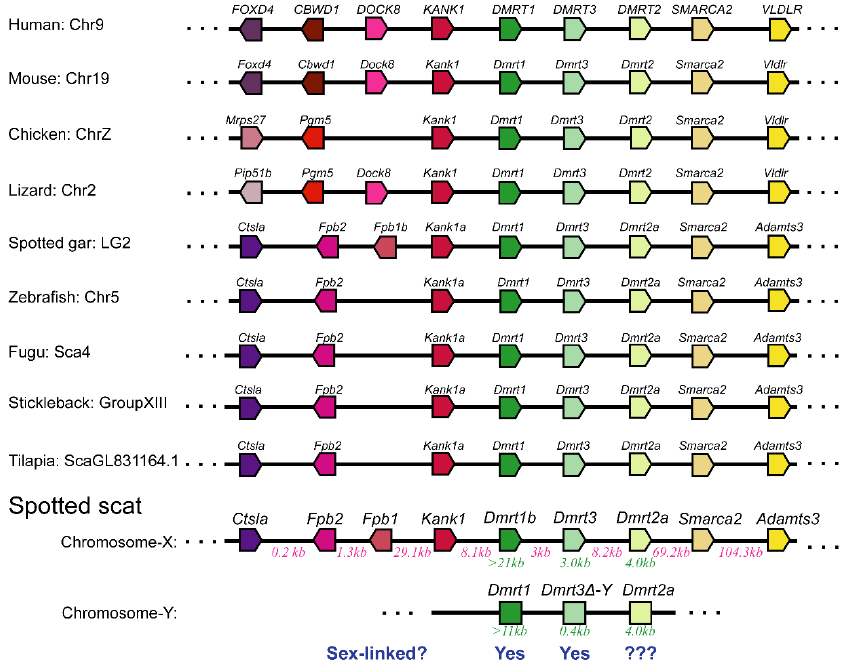
Figure 1. Syntenic analyses of Dmrt1 and Dmrt3 and their adjacent genes in different species. The figure was adopted with modifications from [3]. The bar lengths are disproportionate to the distances between genes. Dmrt1 and its downstream gene Dmrt3 △ -Y are sex-linked in spotted scat, whiles Dmrt2a is unknown. The distance between spotted scat Dmrt genes is shown in red (in kb). The lengths of Dmrt genes are shown in green (in kb). The neighbor genes of Dmrts on the X-chromosome were obtained from our previous XX genomic data (https://ngdc.cncb.ac.cn/search/?dbId=gwh&q=GWHAOSK00000000.1, accessed on 5 February 2022).